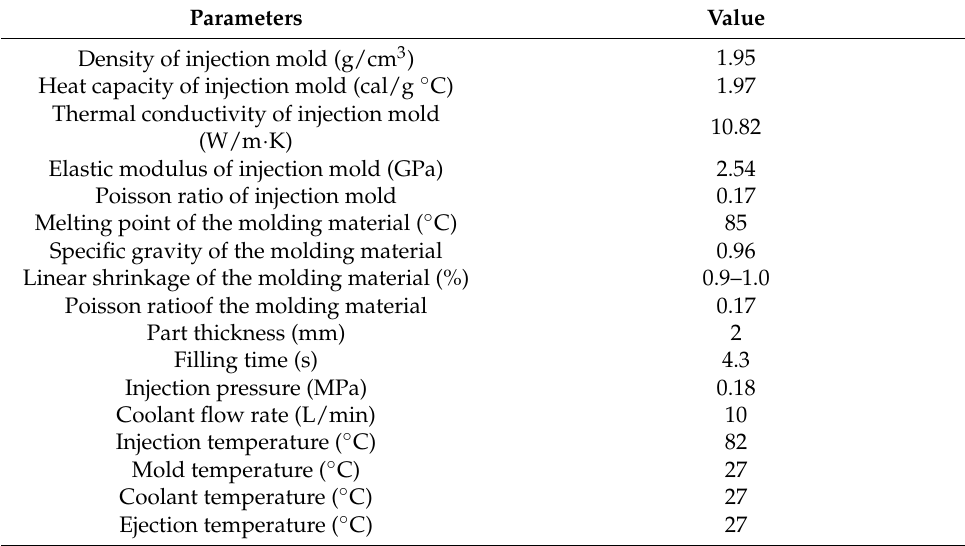
Table 2. Boundary and initial conditions for numerical